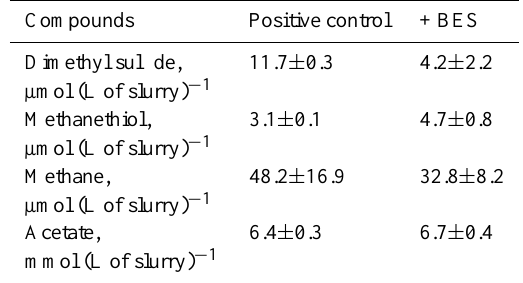
Table 2. Effects of 20mmolL − 1 2-bromoethanesulfonate (BES) on formation of dimethyl sulfide, methanethiol, methane and acetate after 12 days of incubation. The sediments slurries were added with 200kPaH 2 and 10mmolL − 1 bicarbonate. Results are presented as means and standard errors from duplicate tubes.